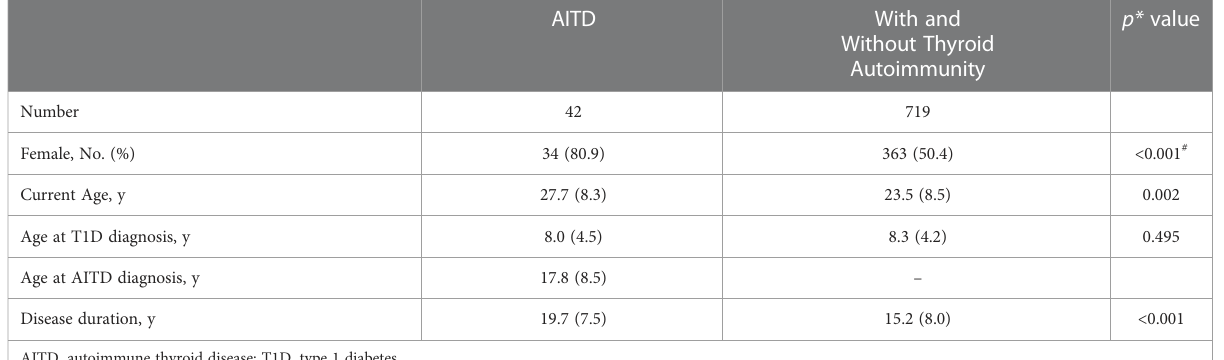
TABLE 2 Comparison between patients with AITD and those without AITD.